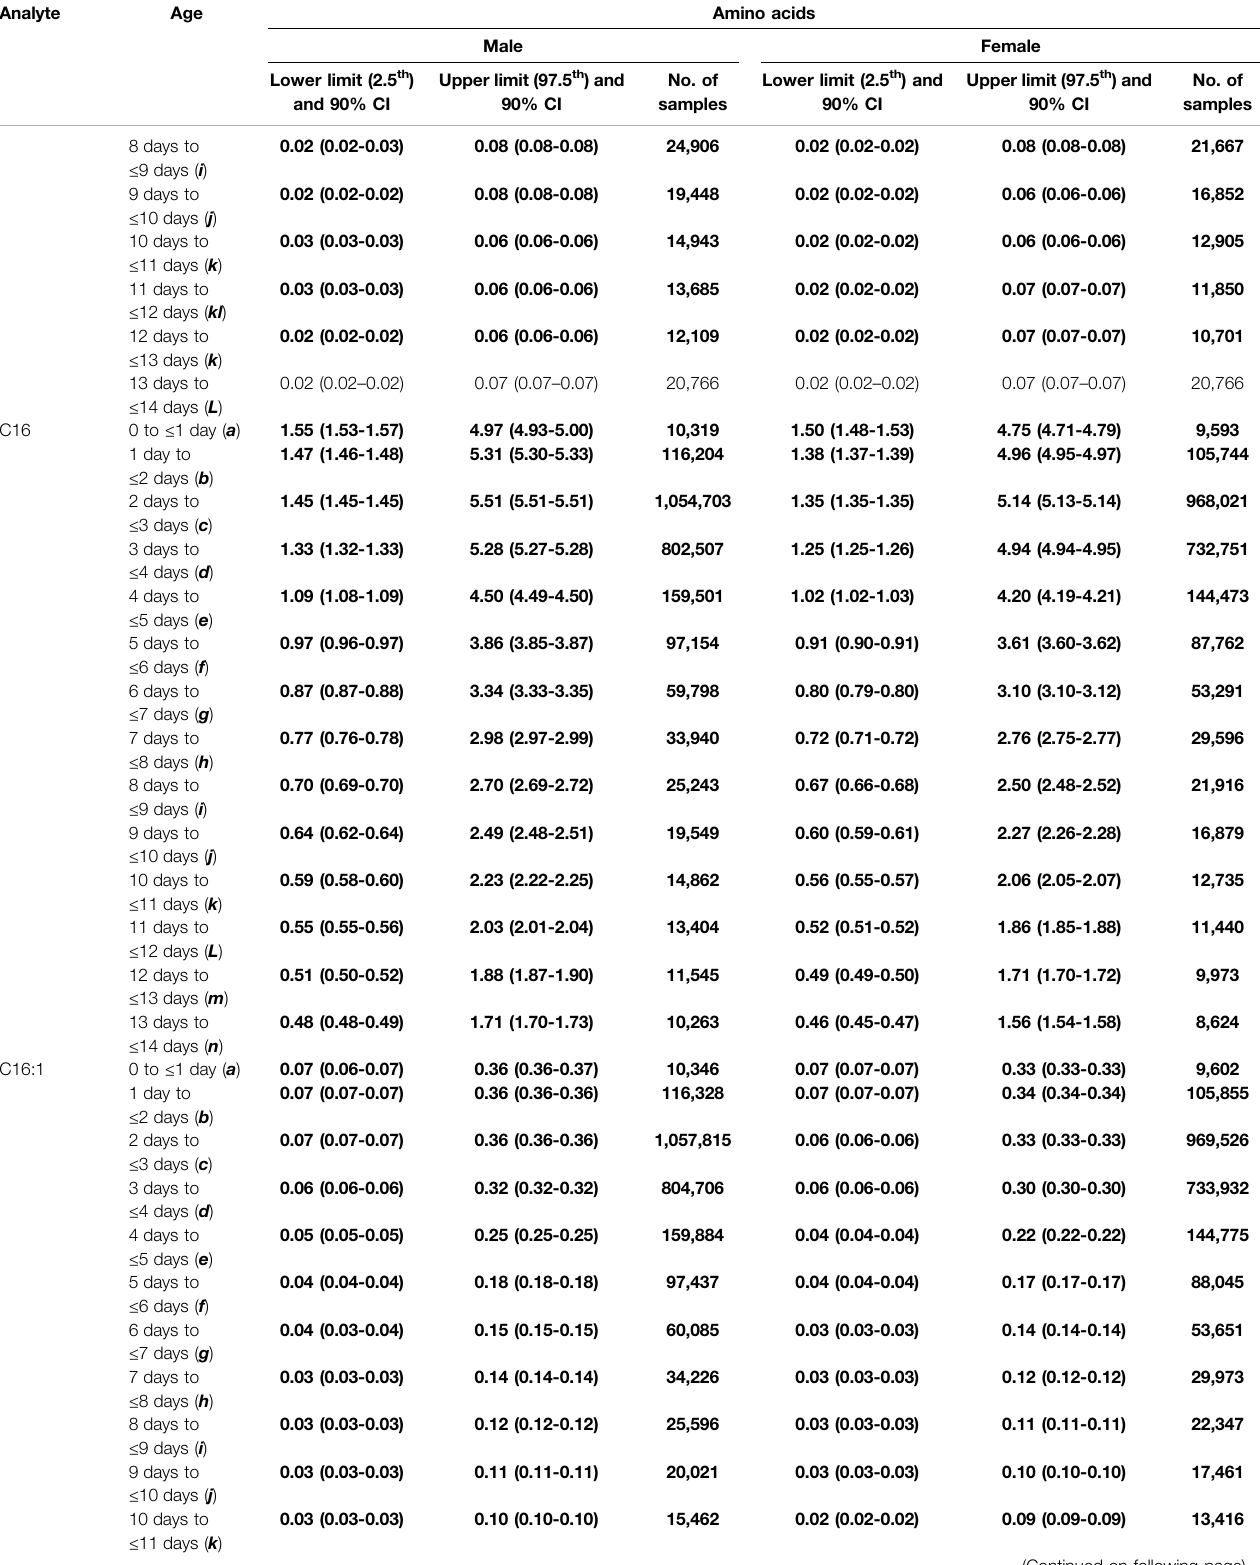
TABLE 2 | ( Continued ) The Reference intervals partitioned by each day and sex for 35 MS/MS NBS biomarkers ( μ